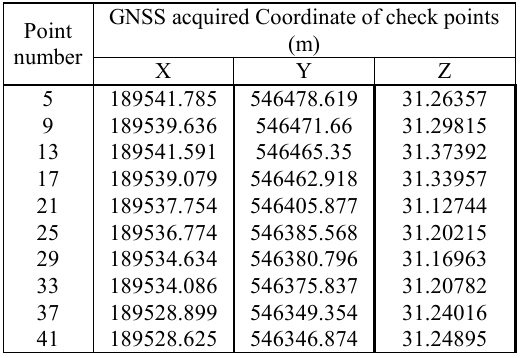
Table 3. Check point coordinates acquired by GNSS device Table 4 below shows the coordinates of 10 checkpoints obtained by MMS.